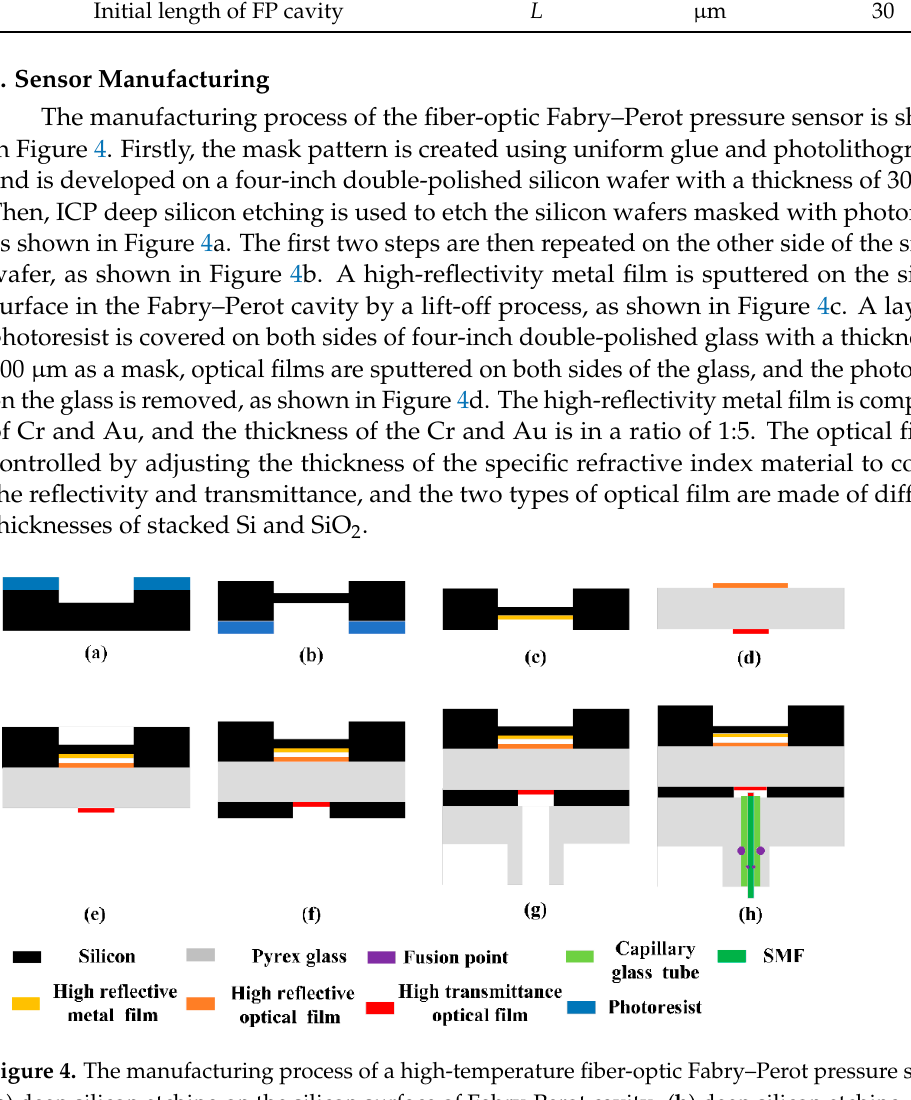
Figure 5. The diagram of finished sensors: ( a ) mass-produced sensitive units of the sensor, and ( b ) the fiber-optic Fabry–Perot sensor. 4. Experiment and Results A high-temperature pressure test platform is developed to test the sensor in a high- temperature environment. The schematic diagram of the experimental setup is shown in Figure 6. The platform consists of a vacuum system, heating system, pneumatic system and water supply system. The sensor test system is mainly composed of the following: a fiber-optic Fabry–Perot pressure sensor; spectrometer; computer; and fiber-optic con- nector. The high-temperature pressure test platform provides a temperature–pressure composite environment for the sensor. The sensor is placed on the ceramic tray with through holes, and the fiber-optic sensor is connected to the spectrometer via a fiber-optic connector.